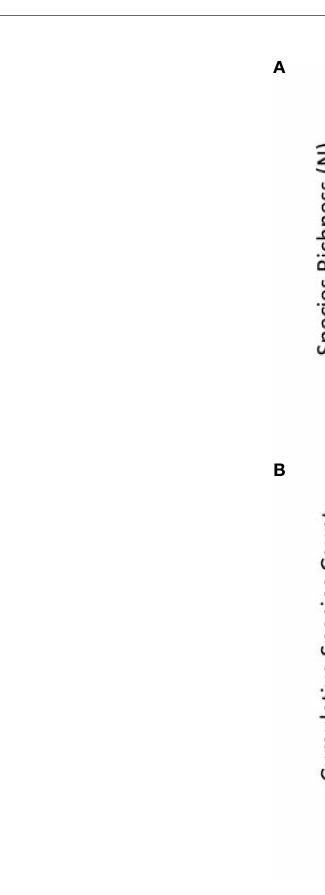
FIGURE 8 | Species richness on the Mid-Atlantic Ridge (41°-60°N) derived from the depth range data in Figure 6 and Table 3 assuming species occurrence is continuous between maximum and minimum observed depth. (A) Total species per 100m depth stratum. Red line - fi tted polynomial. (B) Cumulative species count from maximum to minimum depth, Red line- fi tted polynomial. Green line: Linear relationship 1000 - 4000m depth: y = -0.0323x + 131.69 R² =